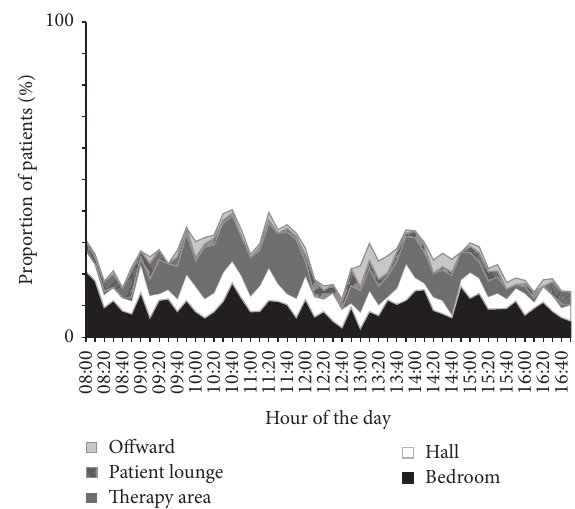
Figure 1: Proportion of patients ( 𝑛 = 104 ) engaged in light or moderate physical activity and their location at each time